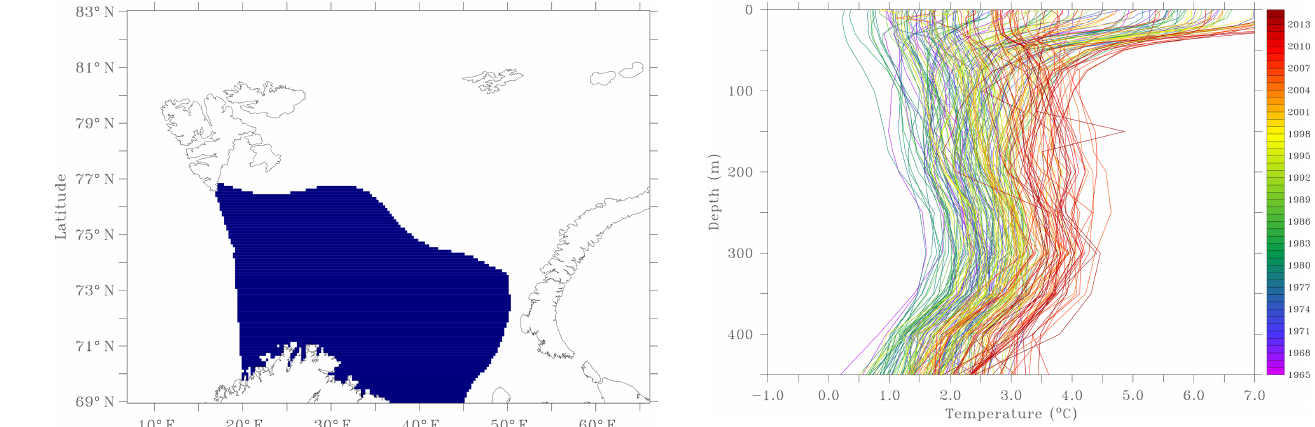
Figure 7. Seasonal averaged profiles of temperature on the most reliable area between 1965 and 2015.